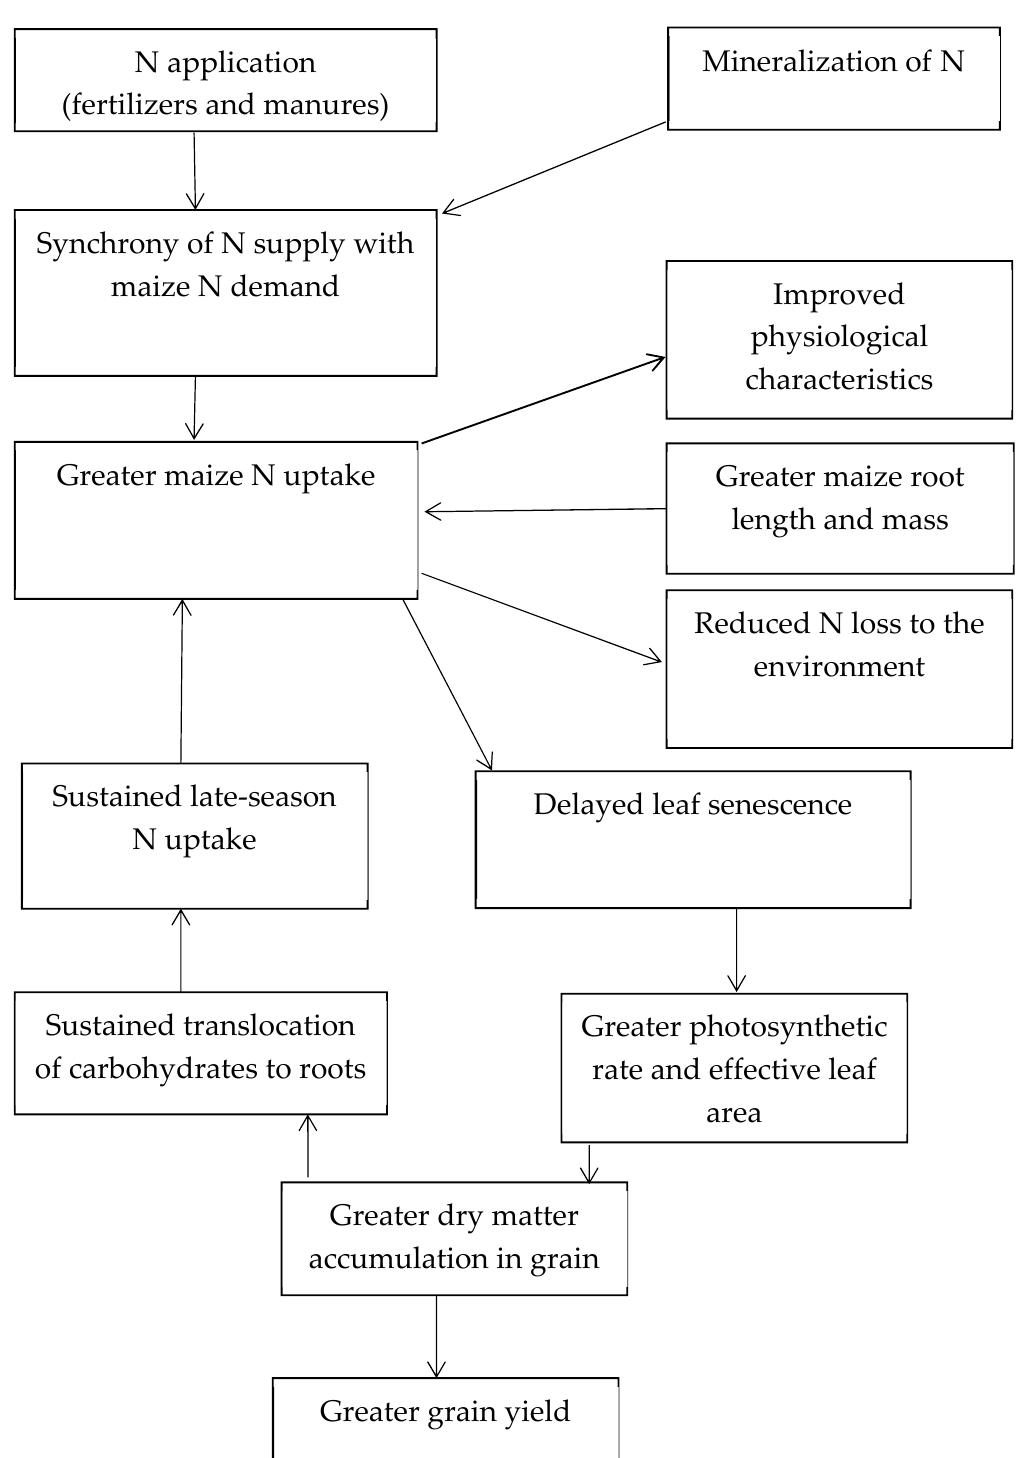
Figure 1. Diagram of nitrogen (N) use in maize.